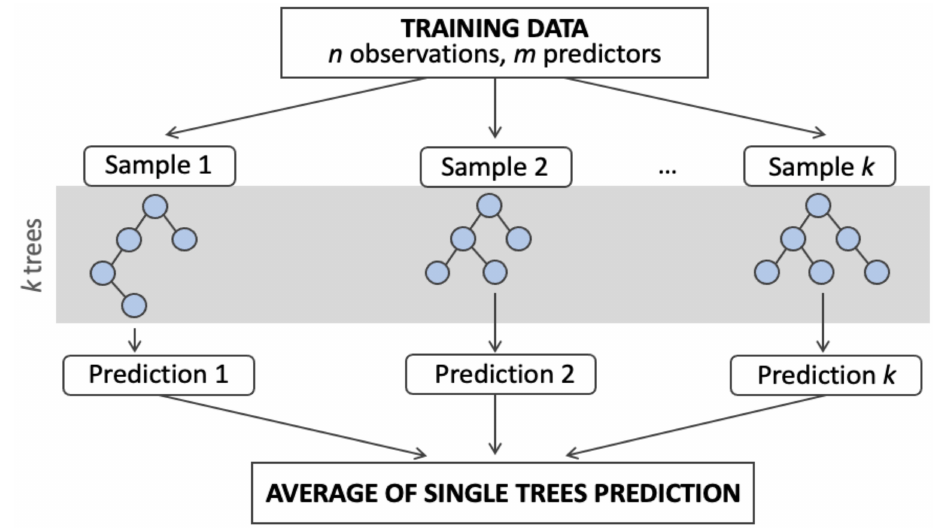
Figure 5. Random Forest prediction structure, after [38].